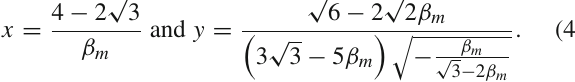
The numerical plot for these horizons is shown in the right panel of Fig. 2. From this figure, one can see that the existence of three horizons satisfy the condition 1 < β m < 2 / as we have analyzed. In the next section, we will use the expression for the horizons derived in this section to analyze the properties of the gravitational potential and the greybody factor of the black